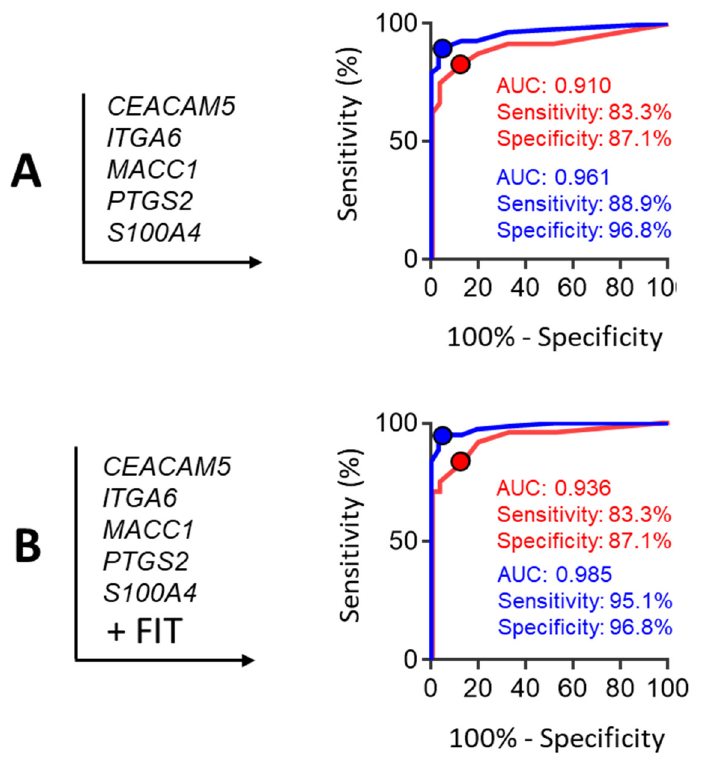
Figure 4. ROC curve analysis of an optimized combination of five of the targets for the detection of patients with AA or CRC as selected from data presented in Table 2. ( A ) ROC curve analysis of the combination of the three targets identified for detecting AA and CRC, CEACAM5, ITGA6 and MACC1 with the two stronger targets for detecting CRC, PTGS2 and S100A4, for AA and CRC. ( B ) Same combination as in A but including the FIT component. AUC is indicated and sensitivity and specificity are provided in % (95% CI).